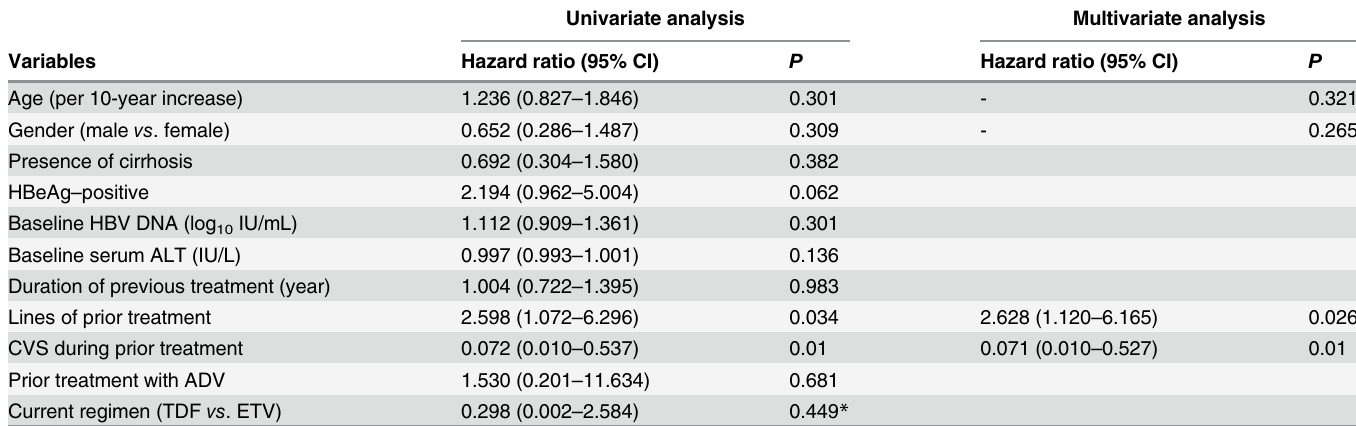
Table 3. Univariate and multivariate analyses of factors associated with virologic